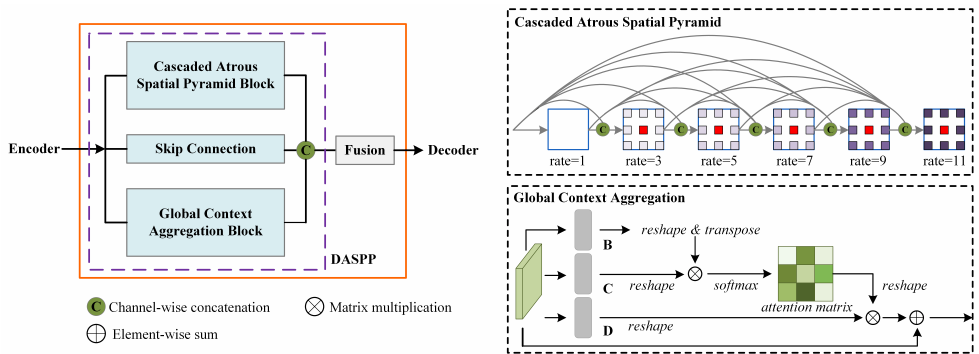
Figure 4. Architecture of the proposed denser atrous spatial pyramid pooling